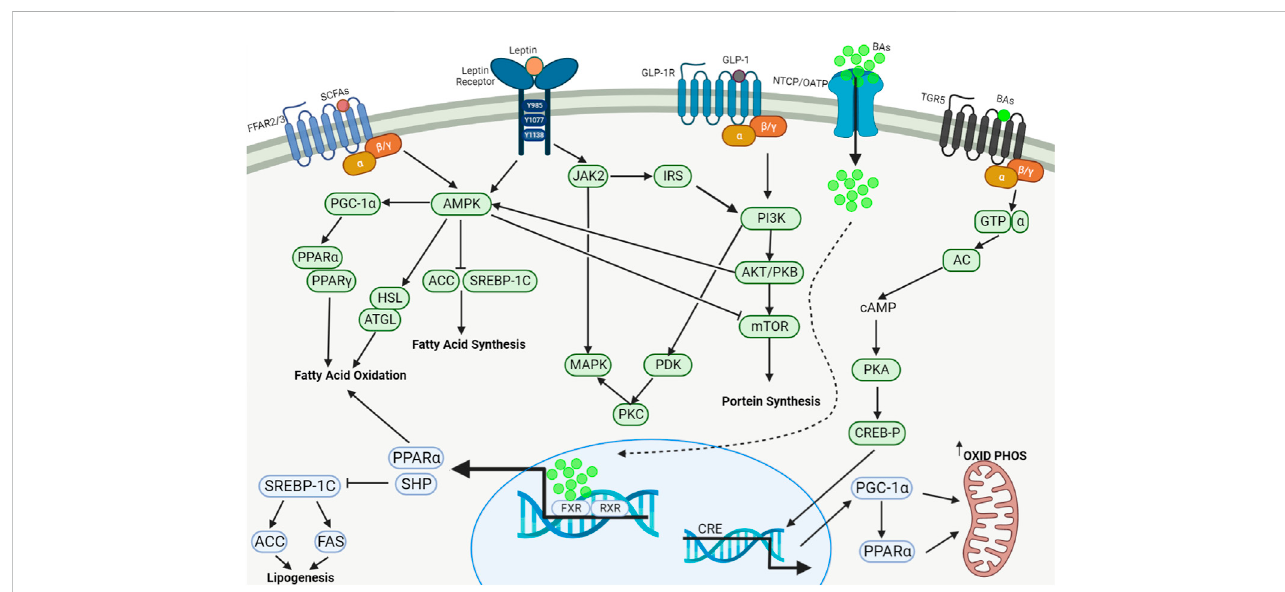
FIGURE 3 Regulation of lipid metabolism by SCFAs, BAs, leptin and GLP-1. The major signaling pathways including AMPK, MAPK, PI3K/Akt/mTOR and cAMP/PKA/ CREB-Pworksystematicallyinconcerttoregulatefattyacidoxidation,fattyacidsynthesis,proteinsynthesisandmitochondrialoxidativephosphorylationand energy metabolism. SCFAs: Short-chain fatty acids; GLP-1: Glucagon-like peptide 1; BAs, Bile acids; FFAR2/3, Free fatty acid receptors 2/3; GLP-1R, GLP-1 receptor; NTCP, Na + -taurocholate cotransporting polypeptide; OATP, Organic anion transporting polypeptide; TGR5, Takeda G protein-coupled receptor 5; AMPK, AMP-activated protein kinase; PGC-1 α , Peroxisome proliferator-activated receptor- γ coactivator 1 α ; PPAR α , Peroxisome proliferator- activated receptor α ; PPAR γ , Peroxisome proliferator-activated receptor γ ; HSL, Hormone-sensitive lipase; ATGL, Adipose triglyceride lipase; ACC, Acetyl coenzymeAcarboxylase;SREBP-1c,Sterolresponseelement-bindingprotein-1c; JAK2,Januskinase-2;MAPK,Mitogen-activatedproteinkinase;IRS,Insulin receptor substrate; PDK, Phosphoinositide-dependent protein kinase; PKC, Protein kinase C; PI3K, Phosphoinositide 3-kinase; AKT, Protein kinase B (PKB); mTOR, Mammalian target of rapamycin; GTP, Guanosine triphosphate; AC, Adenyl cyclase; cAMP, Cyclic adenosine monophosphate; PKA, Protein kinase A; CREB-P, Phosphorylated CREB (cAMP-response element-binding protein); FXR, Farnesoid X receptor; RXR, Retinoid X receptor; CRE, cAMP response element; SHP, Small heterodimer partner; FAS, Fatty acid